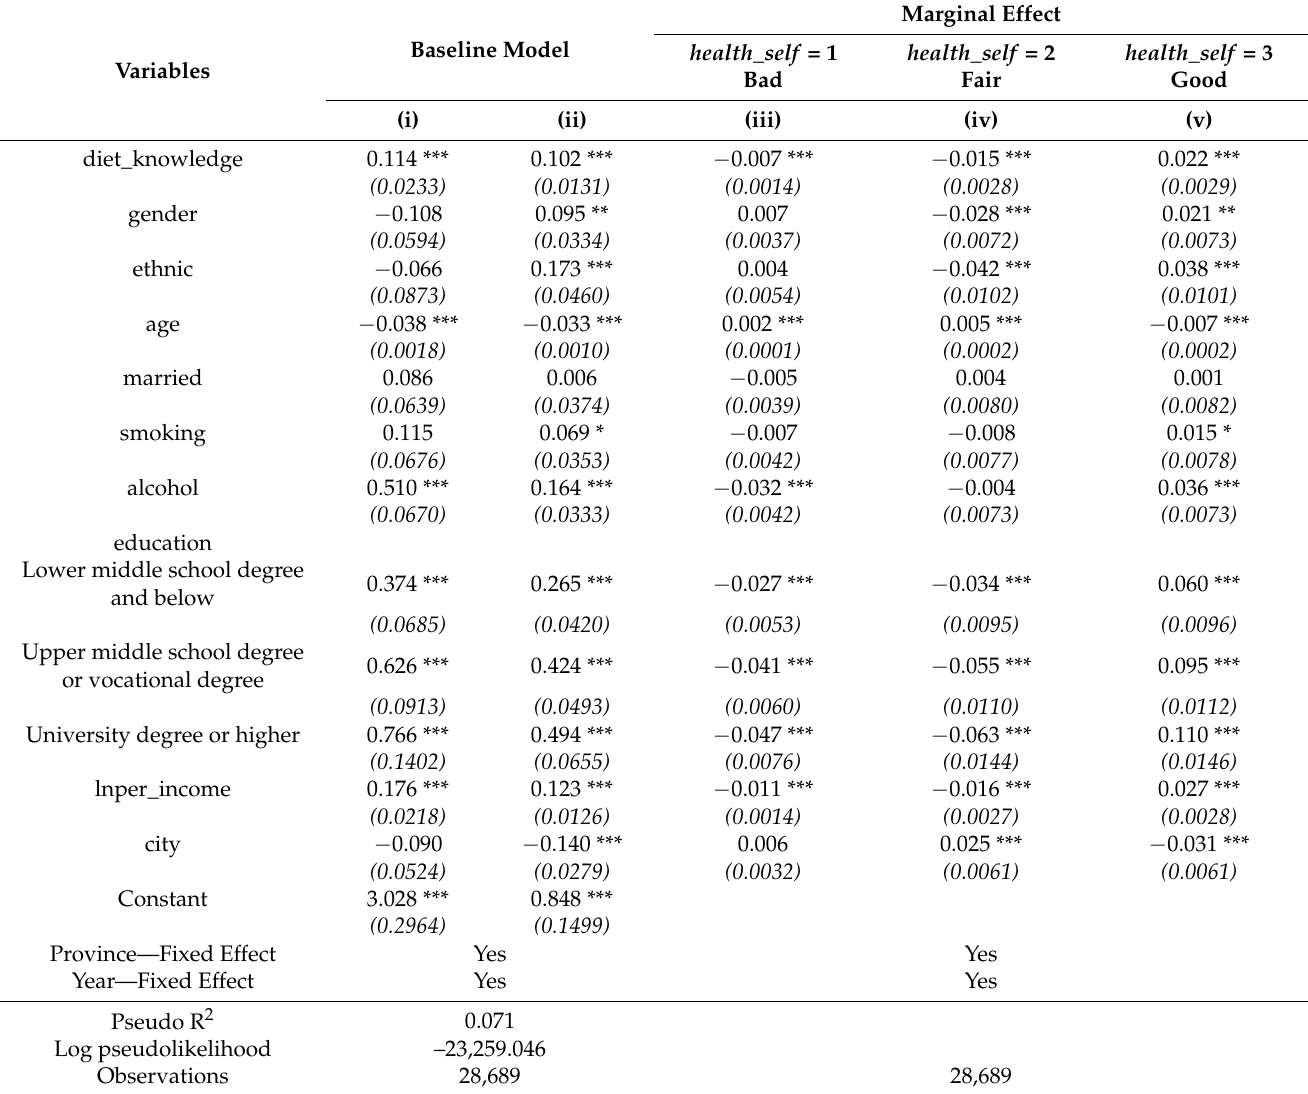
Table 2. Estimation results of the effect of dietary knowledge on health based on the generalized ordinal logit model.